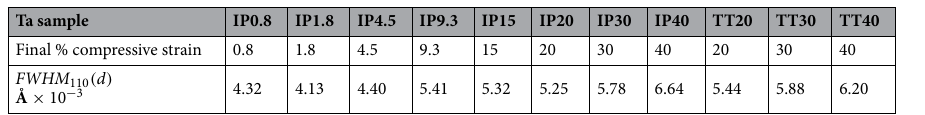
Table 2. Names used to refer to the 11 Ta samples are shown alongside the compressive strain at which the respective diffraction profiles were taken. Full width at half maximum measurements are included for the { 110 }